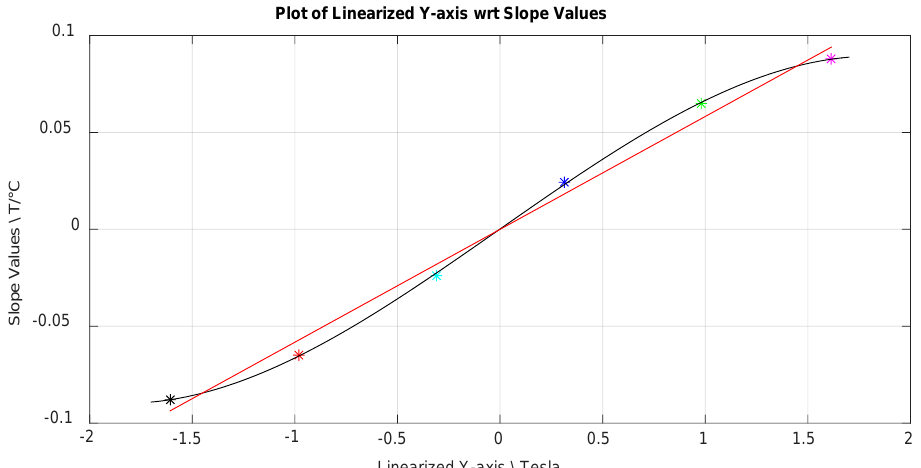
Figure 16. Graph showing the slope values of the errors as in Figure 12 for each plateau. A cubic polynomial (black) is deemed best in characterizing all the slope values across the whole range in comparison to the linear polynomial fit (red).